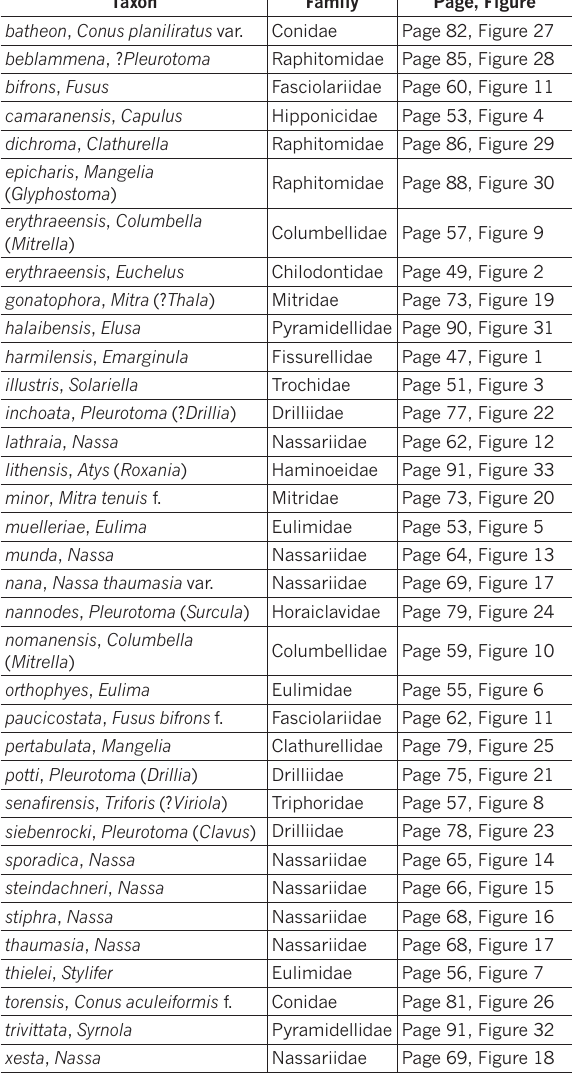
Table 3. List of treated taxa in alphabetical order, with original name, current family placement, and figure in this